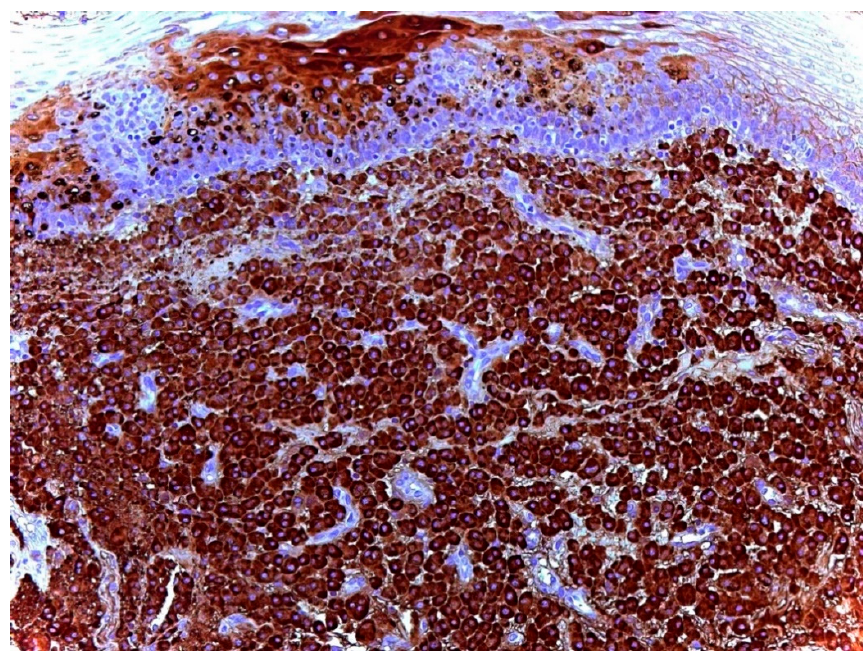
Figure 4. Lambda immunohistochemical expression (monoclonal restriction) in plasma cells (100X/200X).